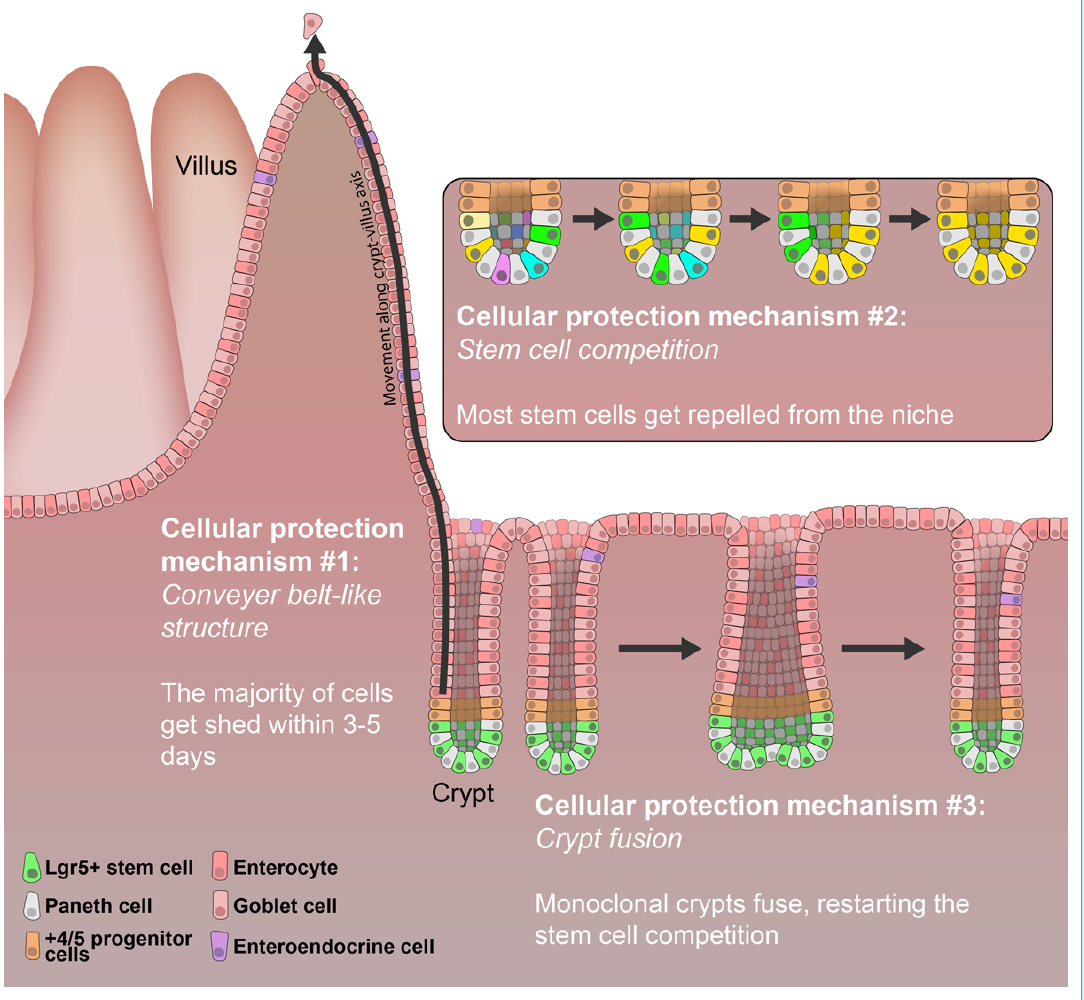
Figure 1: The cellular protection mechanisms against the accumulation of mutations. Cartoon of the crypt-villus units of the small intes- tine. Shown are the three protection mechanisms: 1. conveyer belt-like structure, 2. stem cell competition and 3. crypt